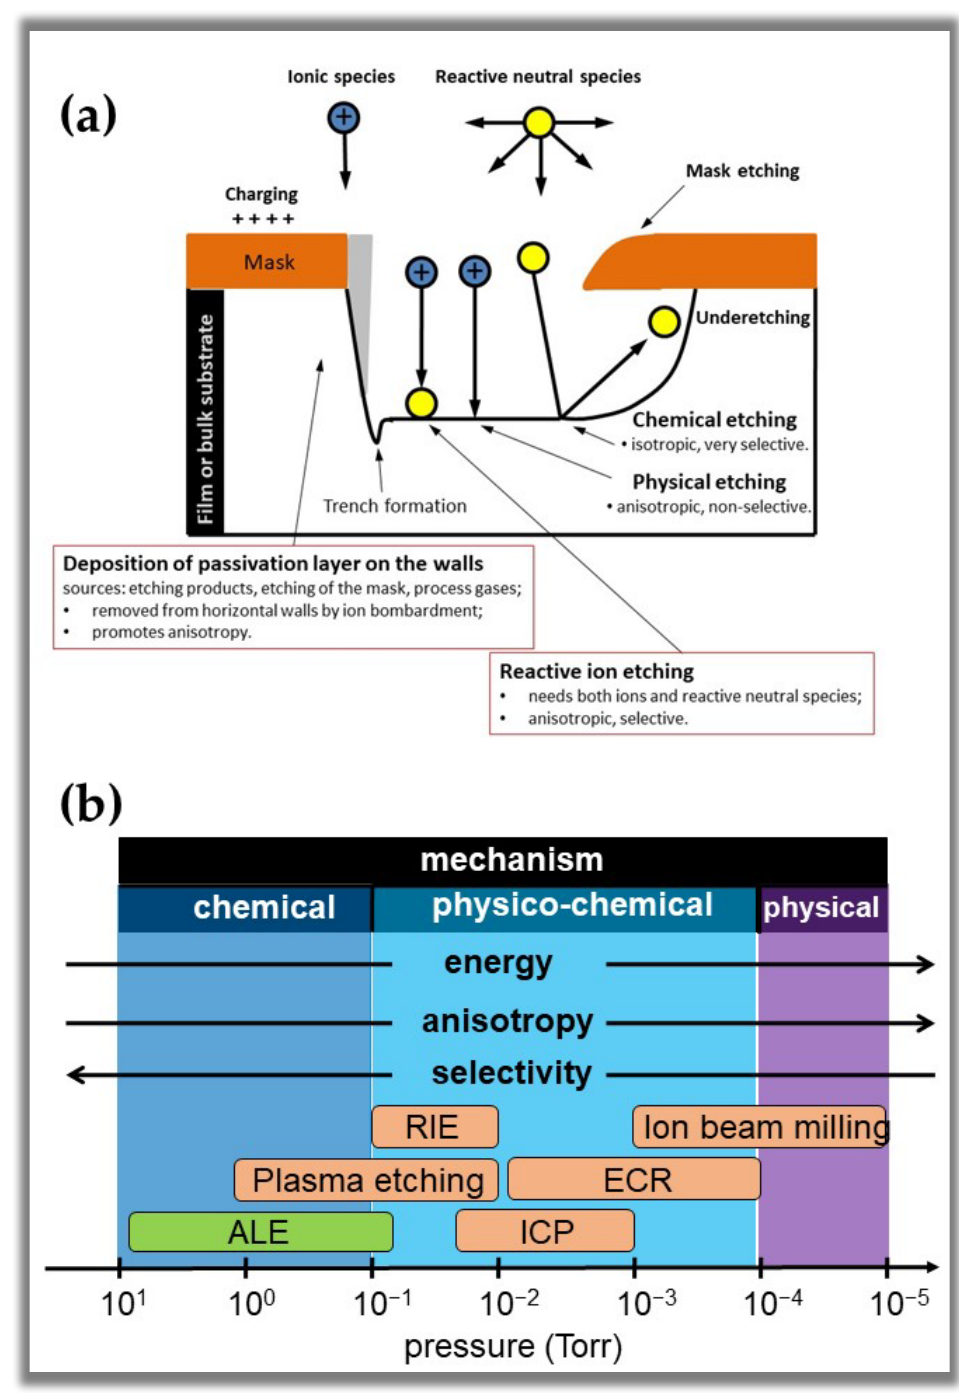
Figure 14. ( a ) Schematic diagram of the main mechanisms governing plasma etching processes and the final shape of the etching profile. ( b ) Dependence on etching mechanisms with the pressure, incident ion energy, anisotropy, selectivity, and reactor types. The direction of the arrow indicates an increase in incident particle energy and anisotropy of the profile formed with decreasing pressure and an increase in selectivity with increasing gas pressure. Symbology: RIE: reactive ion etching, ICP: inductively coupled plasma, ECR: electron cyclotron resonance: ALE: atomic layer etching. This type of mechanism offers anisotropic etching controlled by the energy of the incident ions. High etching rates can also be obtained through this mechanism. However, this mechanism may have low selectivity compared to purely chemical etching due to the incidence of high energetic ions. To solve this problem, it is common to use gases that